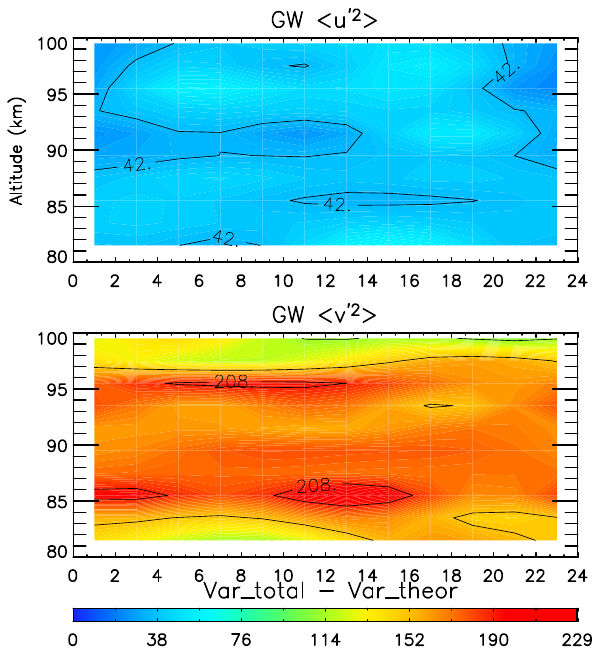
Fig. 11. GW variances after removing tidal contamination. The up- per and lower panels show the zonal and meridional components,